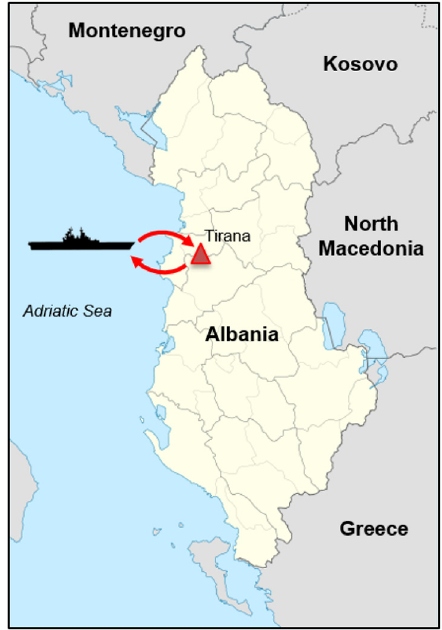
Figure 1. Operation